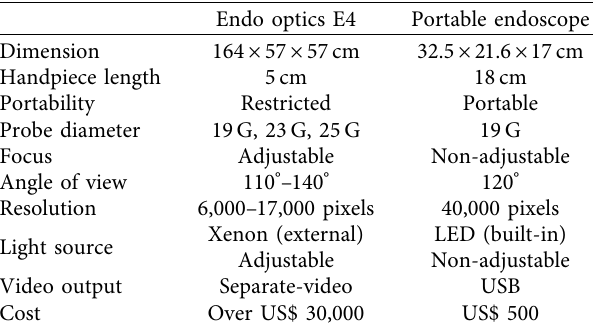
Table 1: Comparison of the ophthalmic